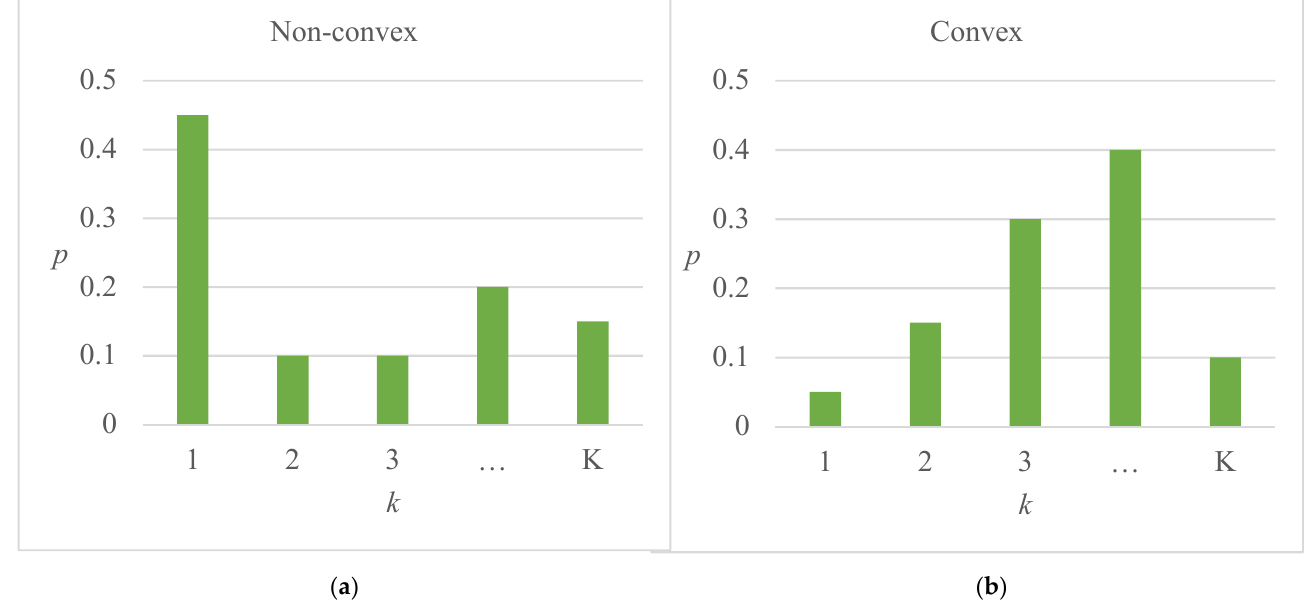
Figure 6. Illustration of rank inconsistency and rank consistency. ( a ) rank inconsistency; ( b ) rank consistency.